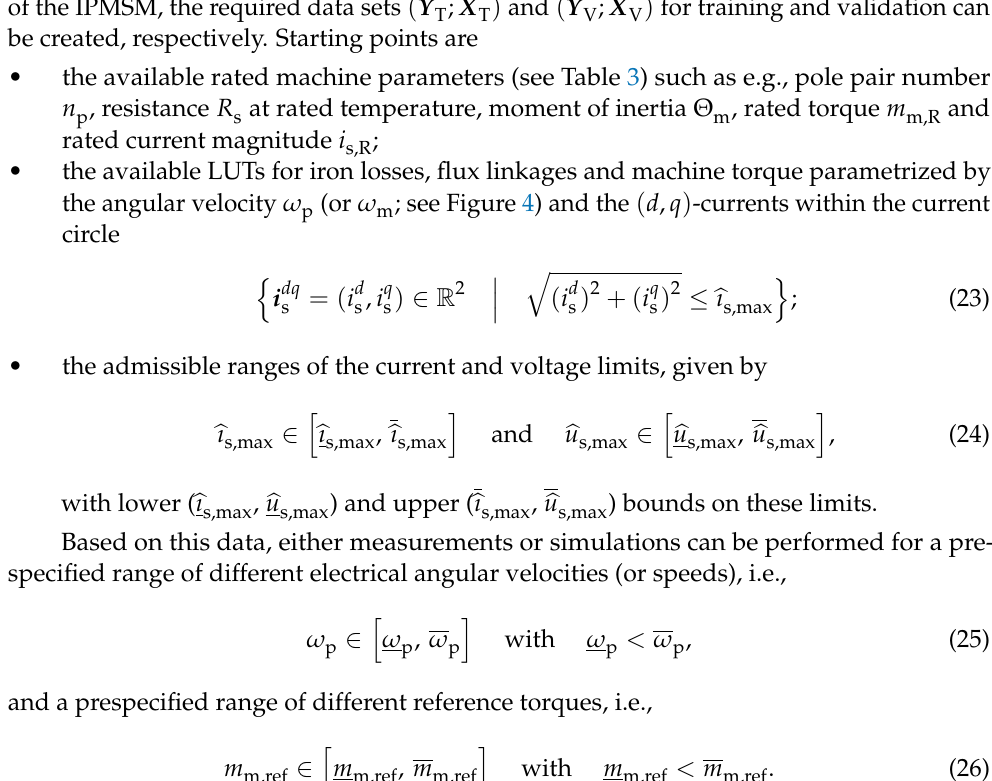
q ) (cid:62) ( i d ) (cid:62) is the difference y = ( i d s,ref , i q s,ref,ANN , i s,ref s,ref,ANN − − (cid:98)